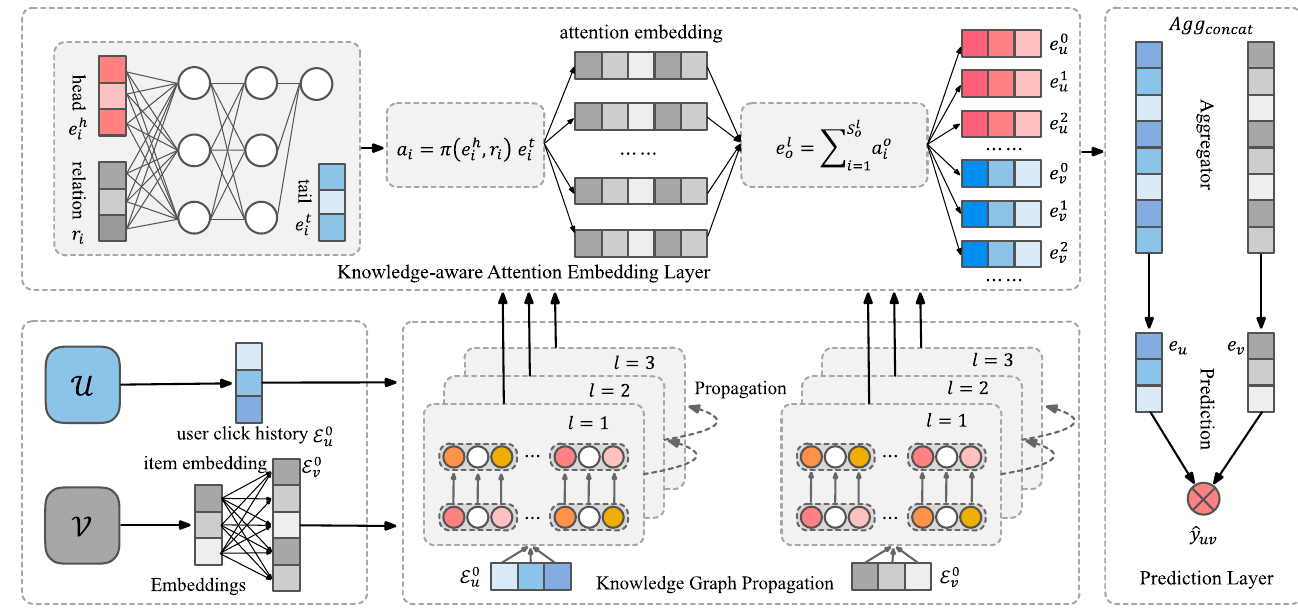
Figure 2. The general structure of the AKGP model. Upon inputting user–item interaction information and knowledge graph, the model calculates the weights of entities with different relationships through attention networks and propagates them in the knowledge graph as propagation factors. This enables us to aggregate and predict user preferences.